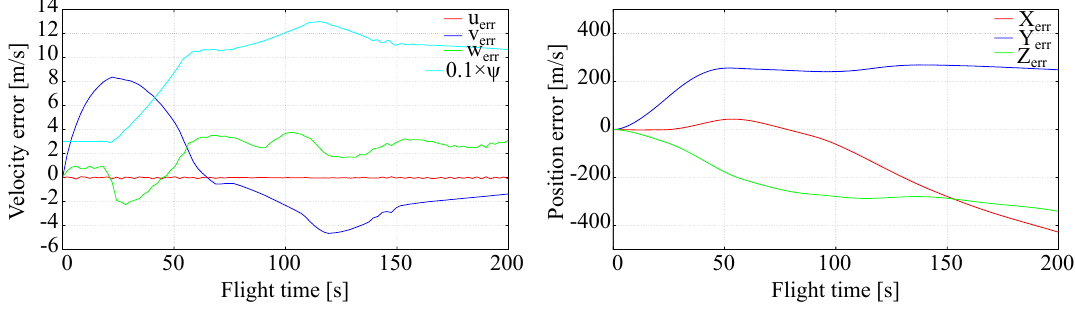
Figure 8. Full tracking in constant wind